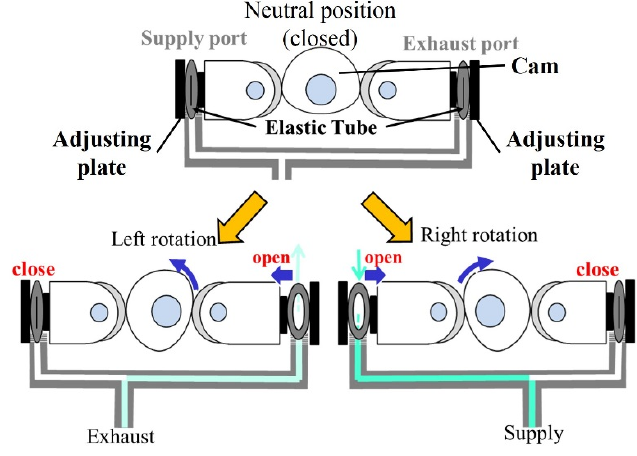
Figure 4. Cam mechanism model (For illustrative purposes, tube directions were changed).